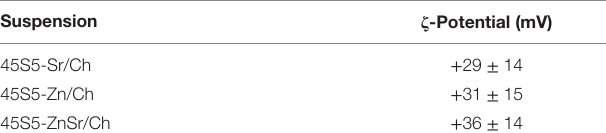
TaBle 2 | ζ -potential results for suspensions containing the different doped bioactive glasses in a mixture with chitosan.